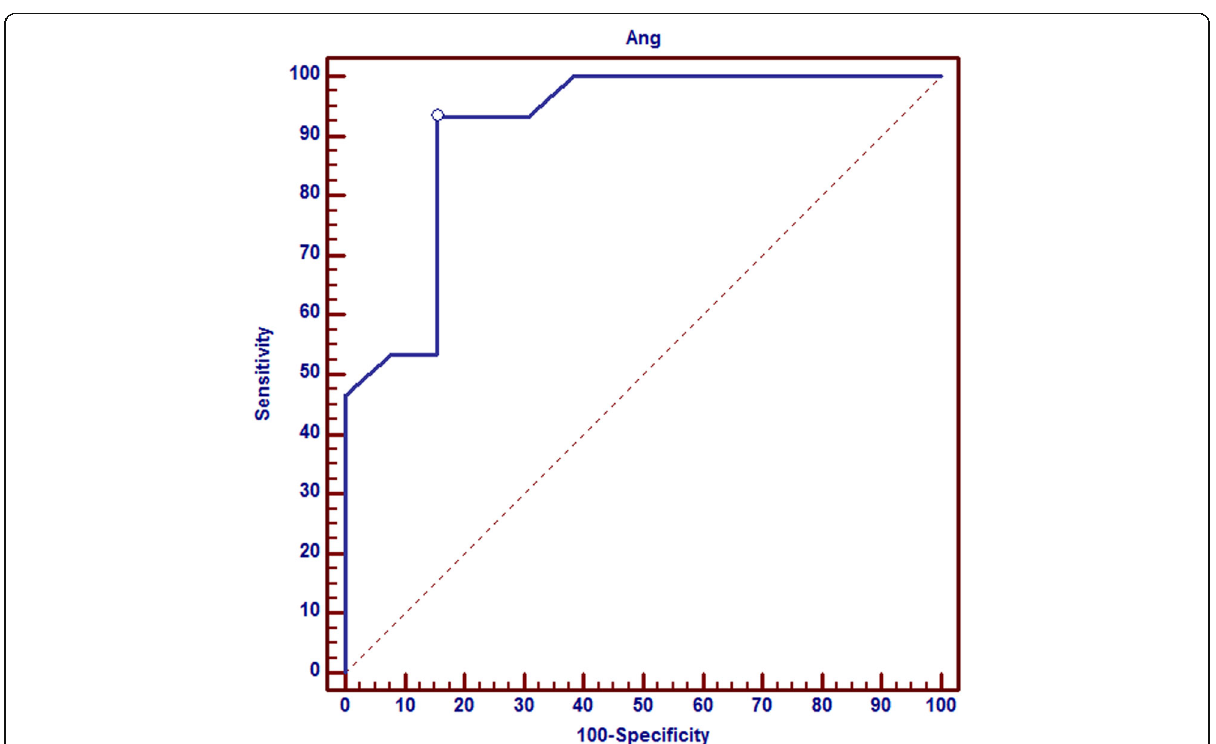
Fig. 8 ROC curve that shows the prediction of vaginal delivery by the angle of fetal head descent